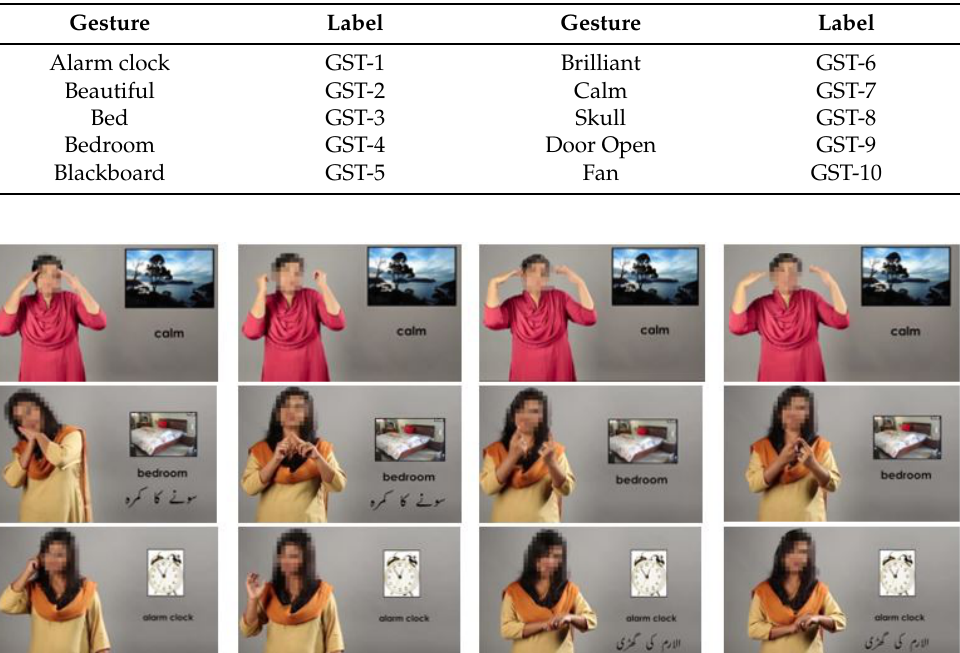
Table 3. Information about the gestures.